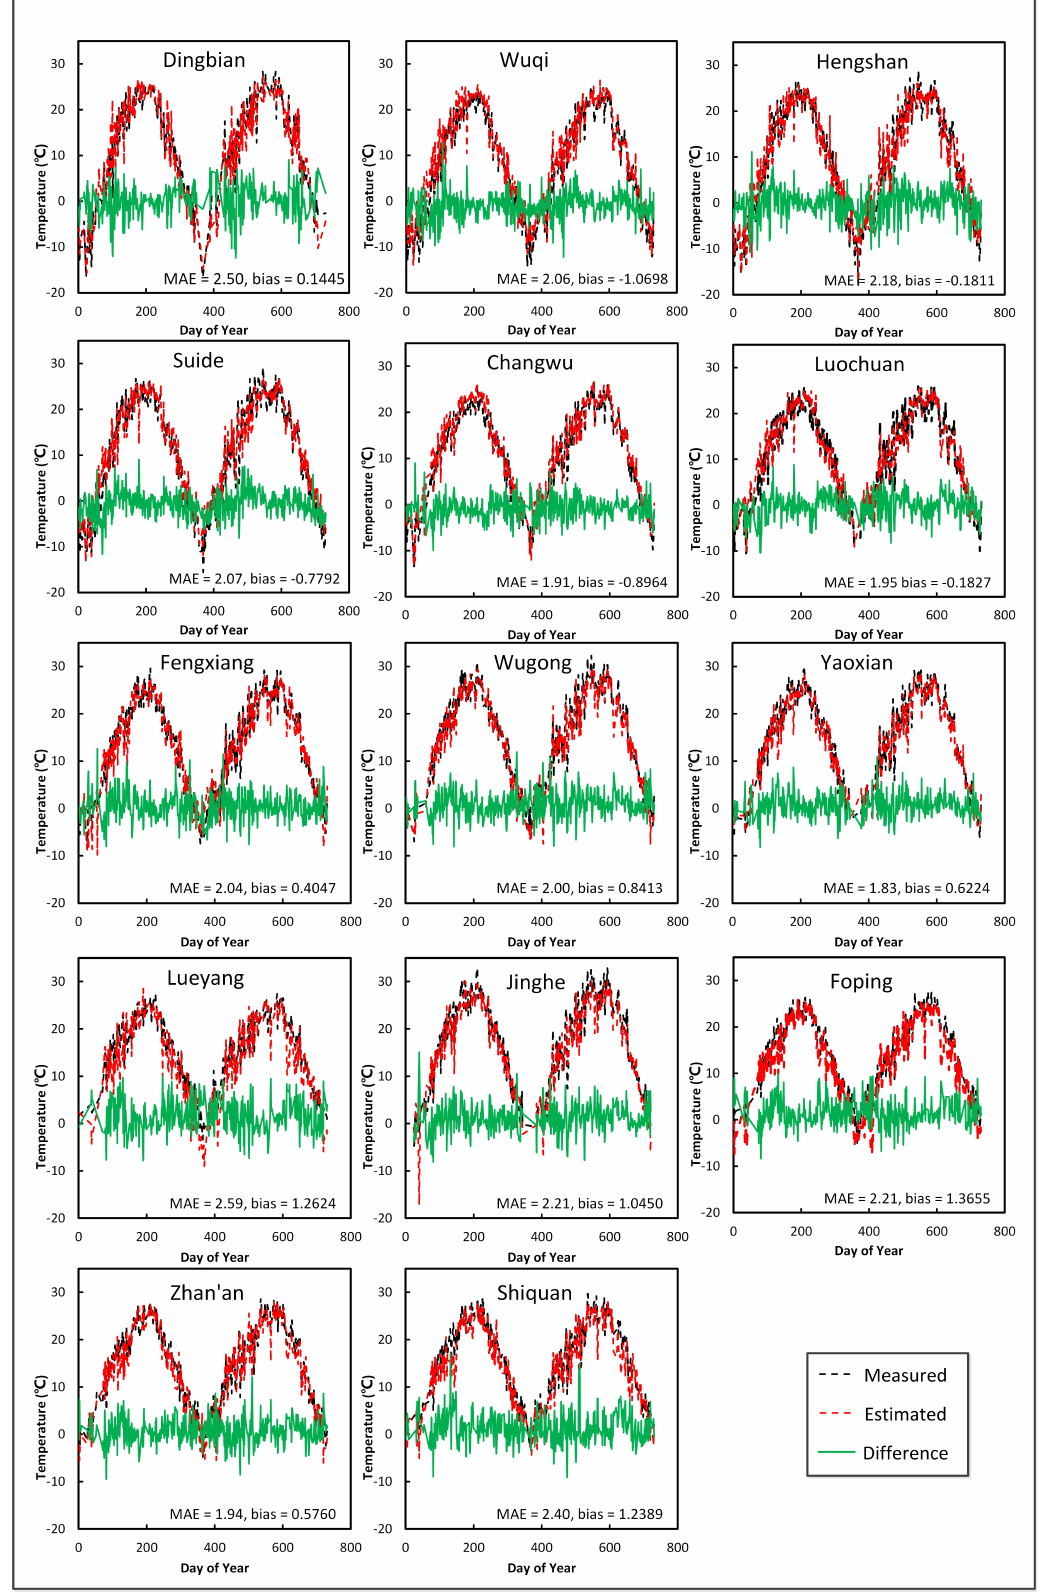
Figure 12. Annual variation in the measured and estimated daily mean air temperature ( TA ) in 2012 and 2013 based on the data from the 14 rural meteorological